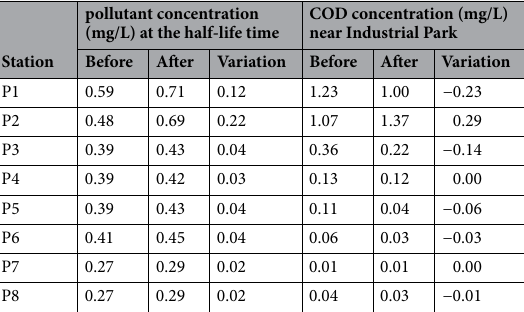
COD concentration (mg/L) near Industrial Park